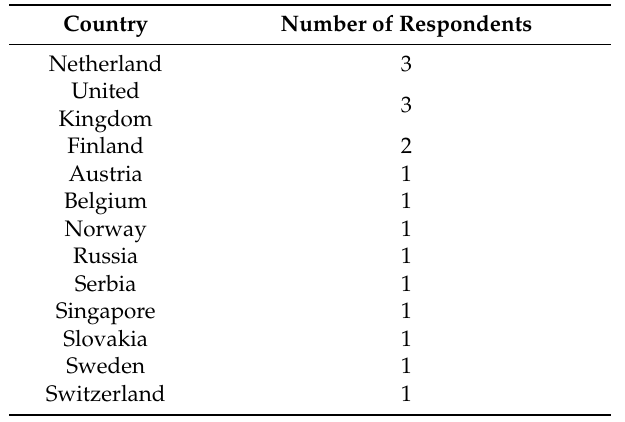
Table 1. Survey sample ( N = 17).